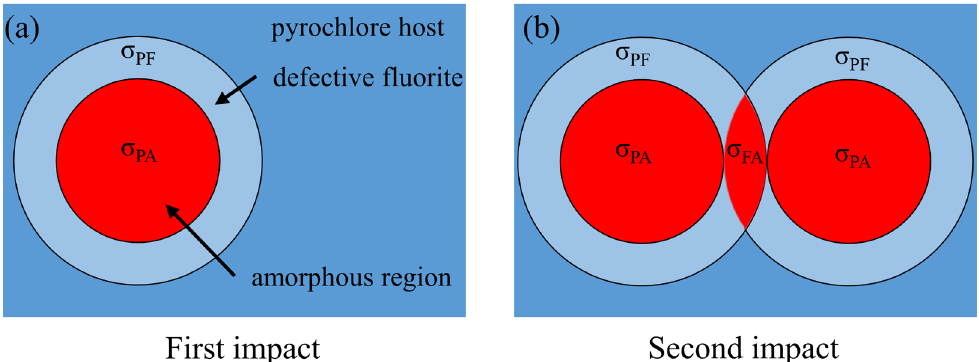
Figure 10. Schematic representations of the physical processes underlying the HTOM model with the cross sections of cylinders corresponding to swift heavy ion tracks: ( a ), first impact, ( b ) second impact. σ PA and σ PF are the areas directly converted by each ion impact into amorphous or disordered regions, and σ FA is the area related to the transformation of a defective fluorite region into an amorphous one owing to a second ion impact.